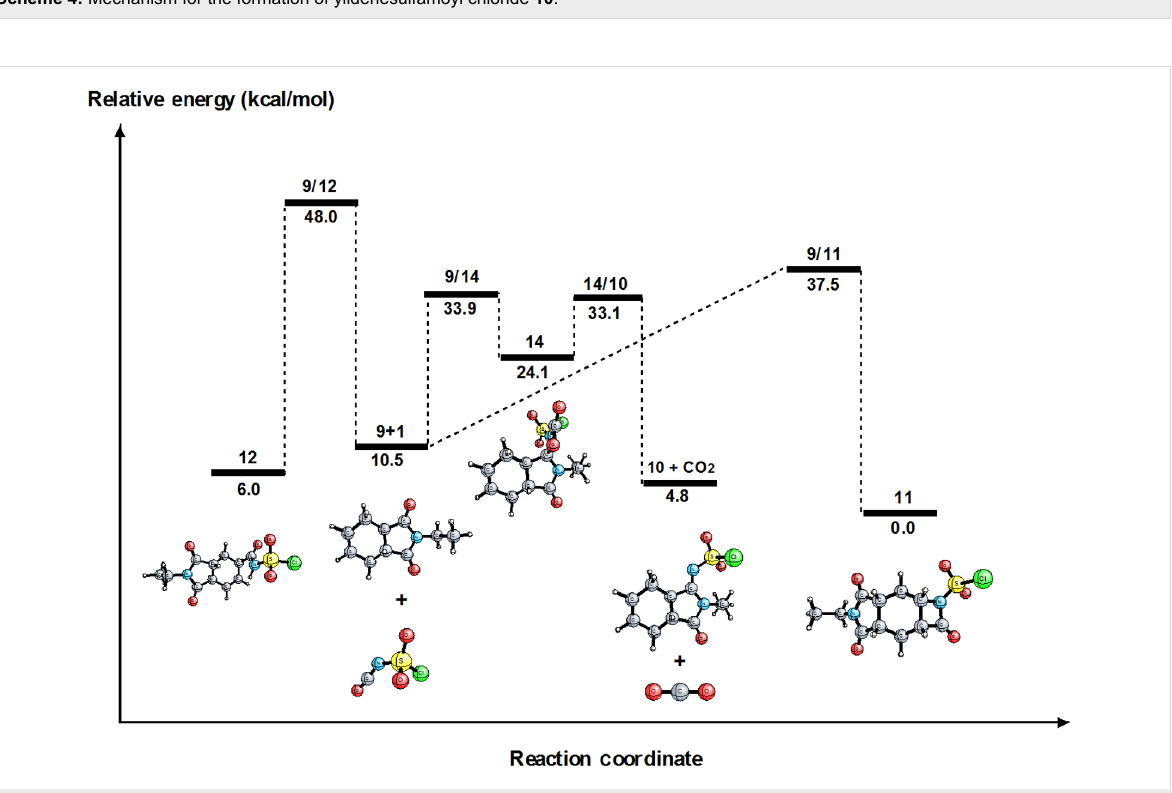
Figure 3: Relative energy profile of the reaction mechanism shown in Scheme 4.